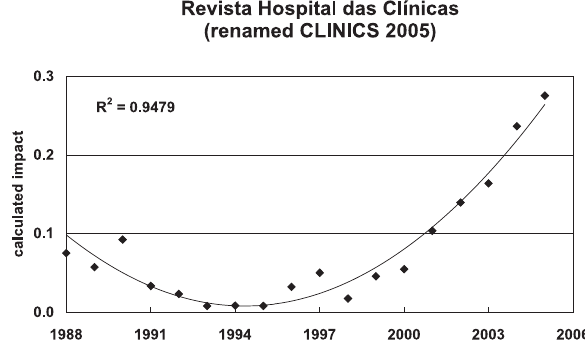
Figure 3 - Case study: calculated impact of the Revista do Hospital das Clínicas, (renamed CLINICS in 2005), in the immediate pre-SciELO and in the SciELO periods. The 2 nd degree polynomial fit exhibits a highly significant correlation coefficient, with a minimum value for the year